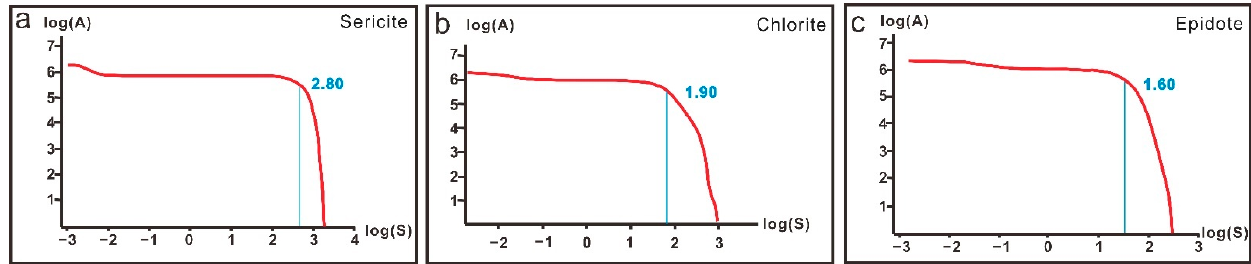
Figure 4. Log(S)-log(A) diagram of the sericite, chlorite, and epidote. ( a ) The fractal filter threshold of sericite is 2.80; ( b ) the fractal filter threshold of chlorite is 1.90; and ( c ) the fractal filter threshold of epidote is 1.60.